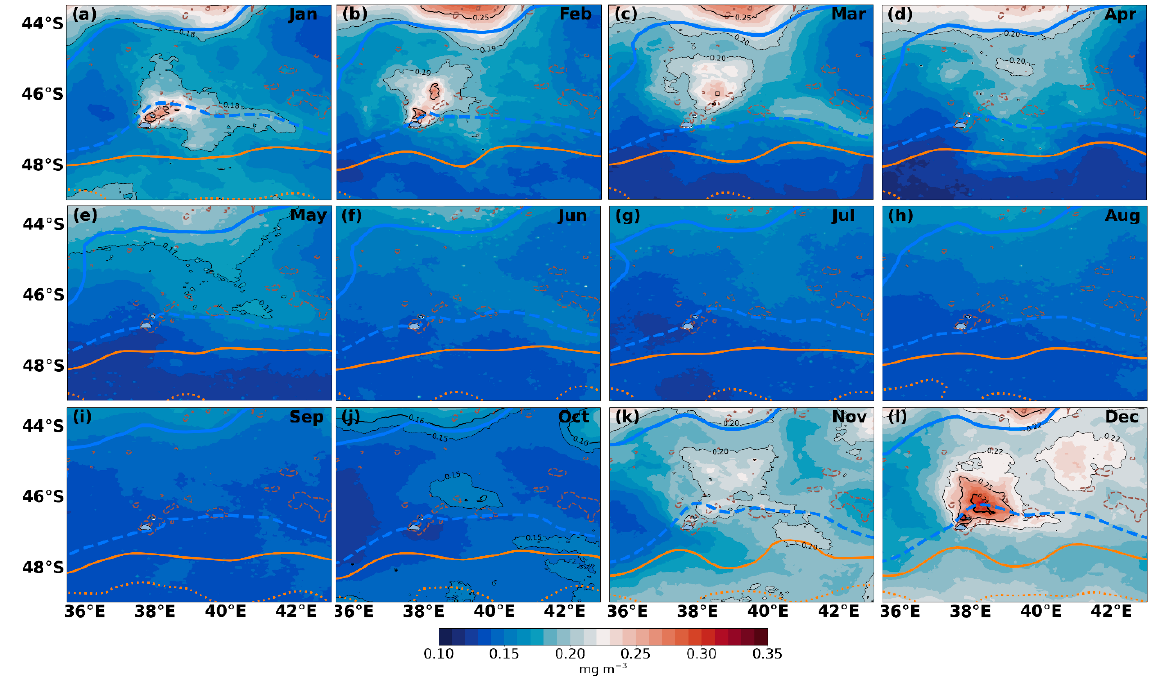
Figure 2. Standard deviation of chlorophyll a (chla; mg m − 3 ) in the Prince Edward Island (PEI) re- gion. The black contours indicate the long-term mean 0.18 mg m − 3 chla isopleths, while the dashed brown contours indicate the 1000 m isobath. The solid and dashed thick blue lines indicate the long- term mean positions of the middle (M-SAF) and southern (S-SAF) branches of the sub-Antarctic Front, respectively, while the solid and dotted thick orange lines show the long-term mean positions of the northern (N-APF) and middle (M-APF) branches of the Antarctic Polar Front, respectively.